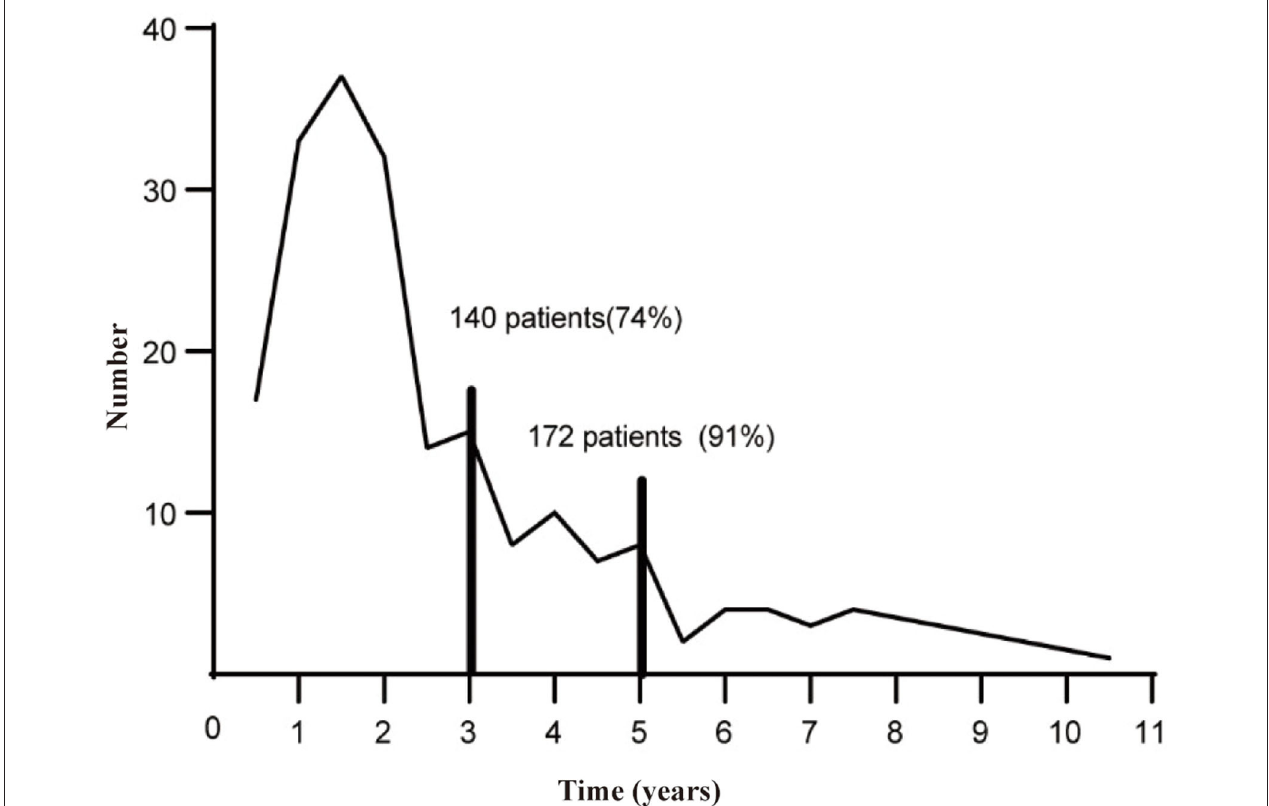
FIGURE 2 | The time chart for patients first